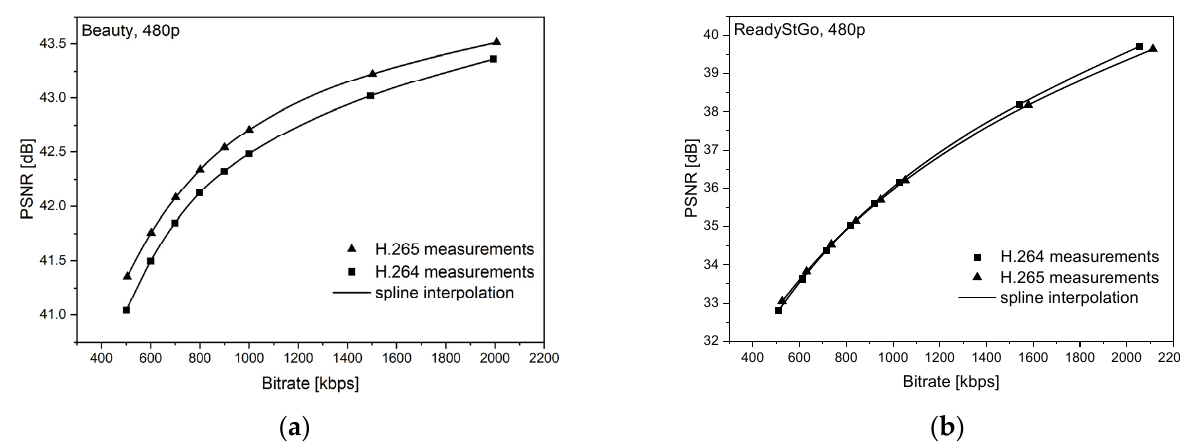
Figure 6. Comparison of the H.264 and H.265 codecs, based on the PSNR metric, for two different videos: ( a ) slow motion video; ( b ) fast motion video.